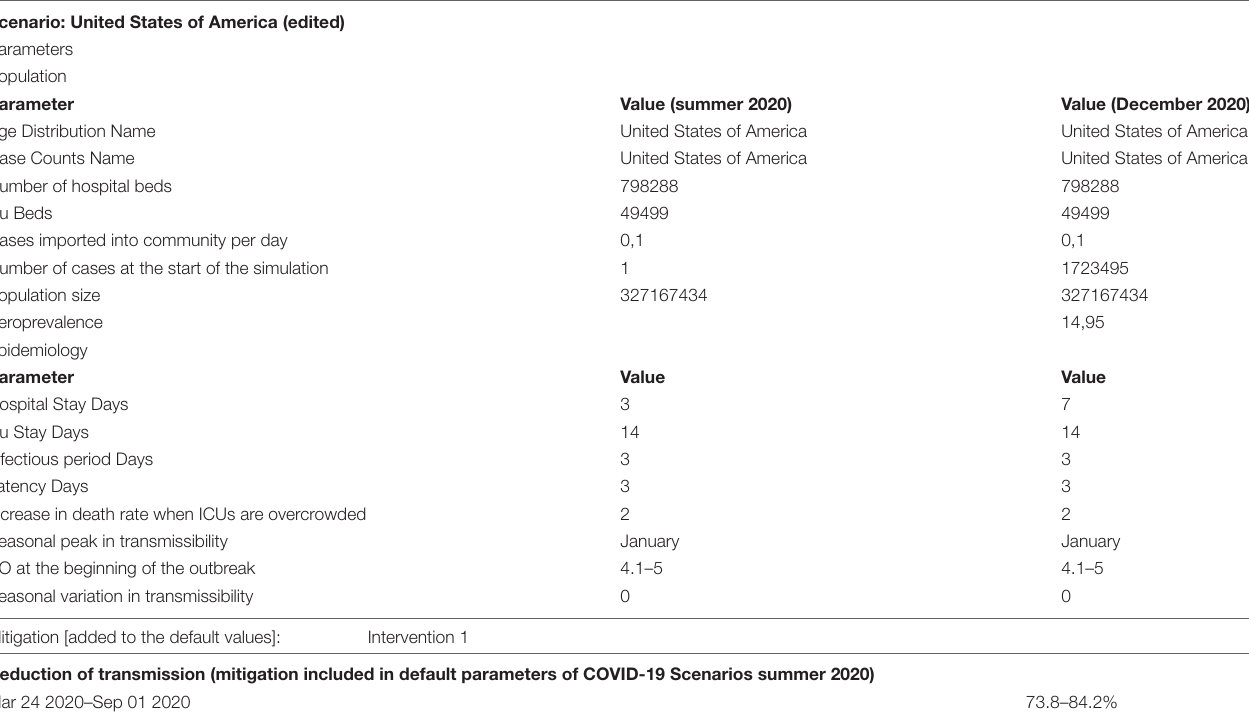
TABLE 2 | Parameters used for COVID-19